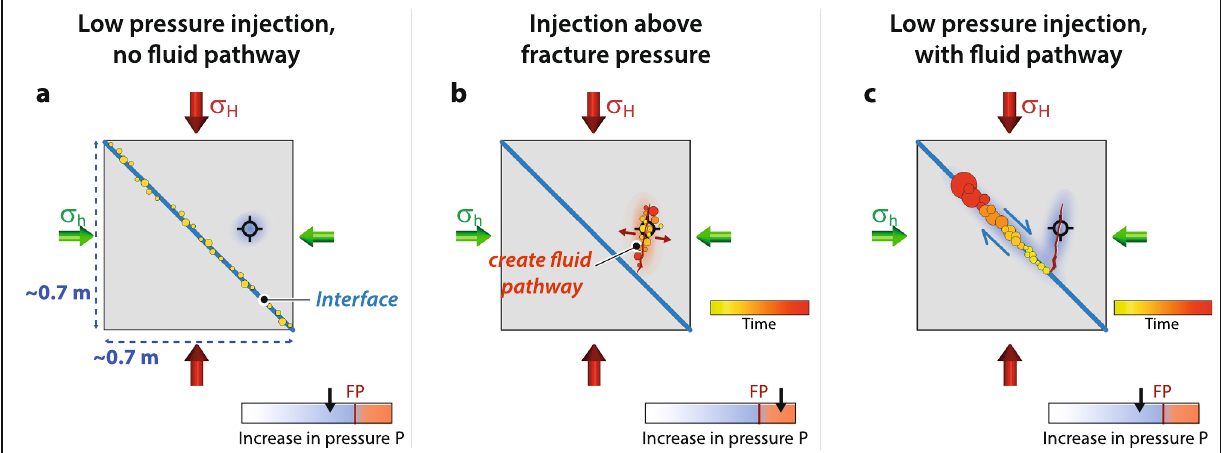
Figure 7. Schematics of three characteristic types of seismicity as observed in the laboratory experiment and analogue field cases. ( a ) Increasing differential stress on interface results in loading-related seismicity on interface. Low pressure fluid injection at an offset injection borehole does not influence seismicity nor creep at the interface as fluid pathways are not connected. ( b ) High-pressure injection creates a hydraulic fracture opening and generates a new pathway for fluids to enter the interface. ( c ) Saturation at interface is increased, and stick–slip movement initiates cascade of AE events moving the whole block or induce a large